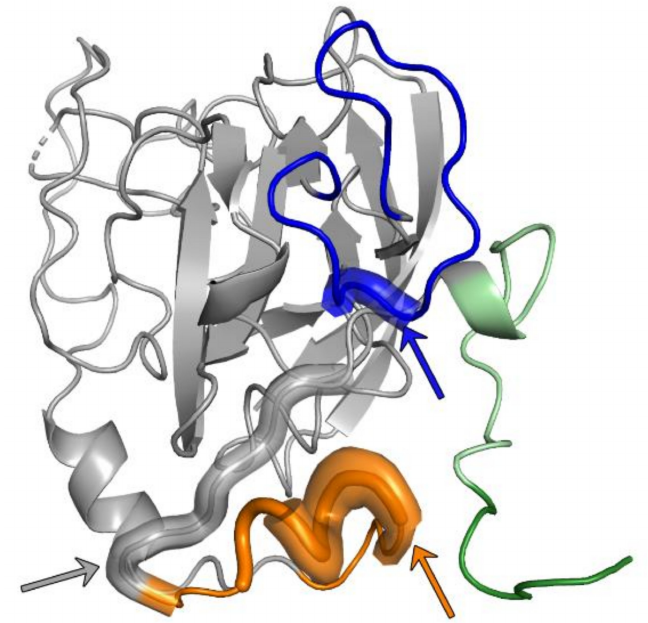
Figure 1. Structurally characterized neutralization epitopes within Hepatitis C virus (HCV) E2. Cartoon representation of the E2 ectodomain crystallized in a complex with HEPC3 and HEPC46 Fab (PDB 6MEJ). The Fab fragments were removed for clarity. The ordered part of the hypervariable region 1 (dark green) and the composite CD81 binding site consisting of epitope I (aa412–423; palegreen), epitope II (aa434–446; orange) and the CD81-binding loop (aa518–535; blue) are highlighted in color. A conserved frontlayer epitope (residues 427–434, 438–443 and 529–531) that is targeted by several bnAbs derived from the VH1-69 germline gene (see text) is indicated by wider and transparent cartoon segments and labeled by colored